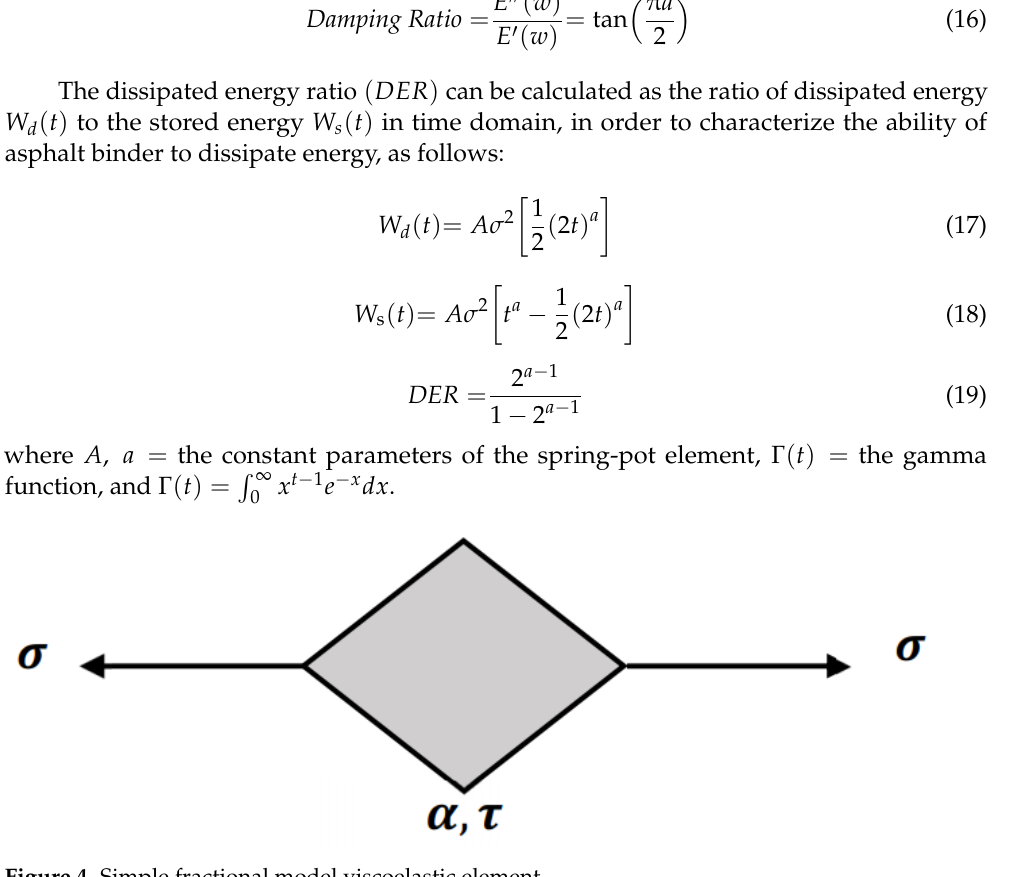
Figure 4. Simple fractional model viscoelastic element.